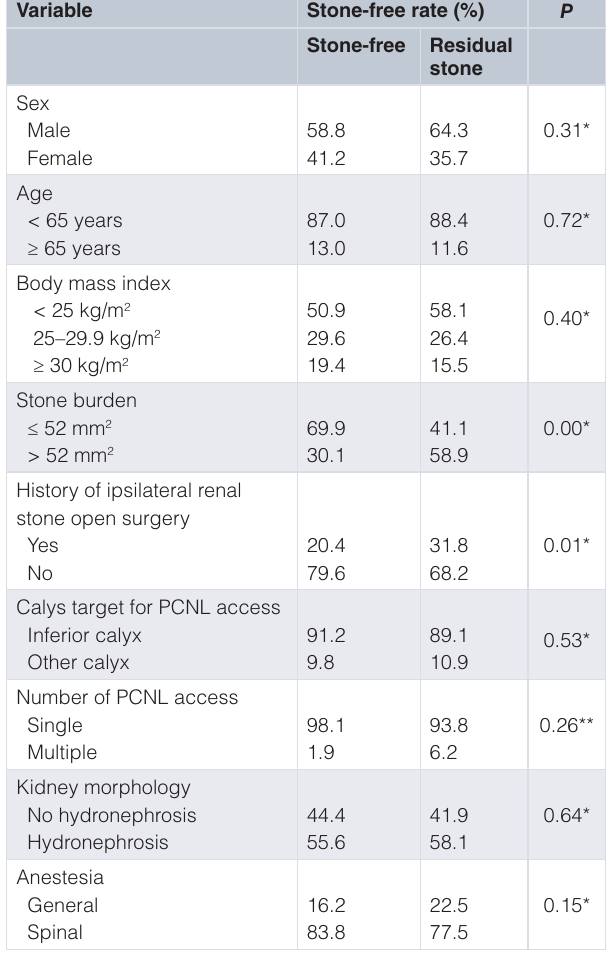
Table 1. Patient characteristics.